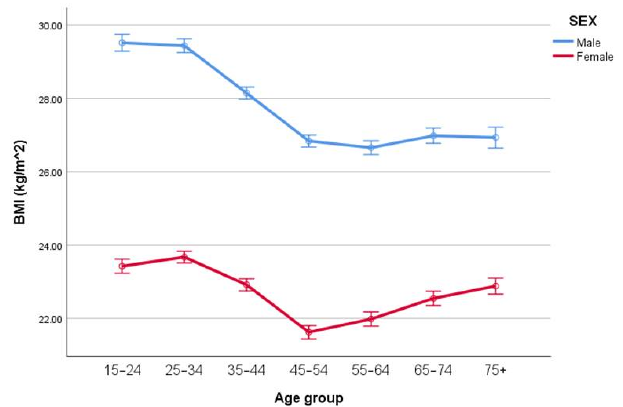
Figure 5. BMI (mean ± SE) by age and sex, adjusted for BF%, data provided by the authors from Nevill and Metsios [3].